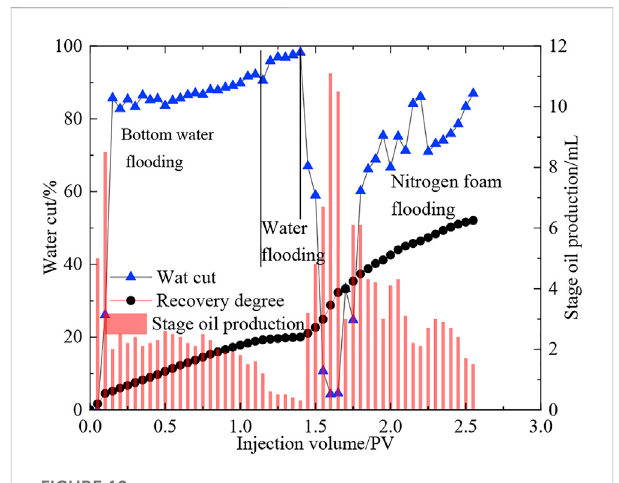
FIGURE 10 Recovery curves at different displacement